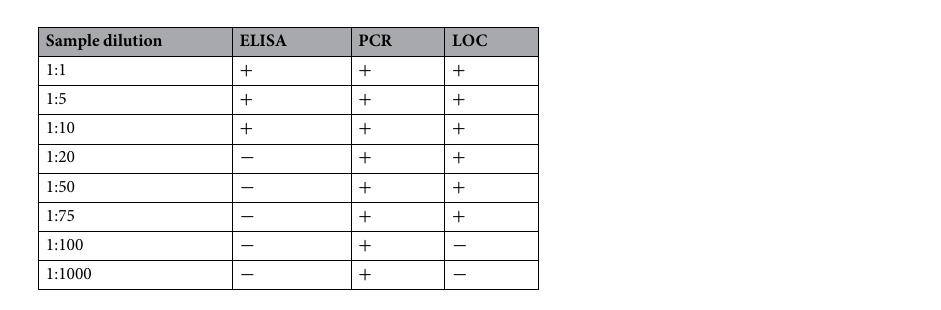
Table 2. Results from analysis carried out on leaves homogenate spiked with known quantity of Xylella fastidiosa . All tests were performed blindly in parallel with ELISA, PCR and LOC methods. A comparison of results in terms of sensitivity reveals that LOC is more effective to detect X. fastidiosa with respect to ELISA technique, while PCR reach the best